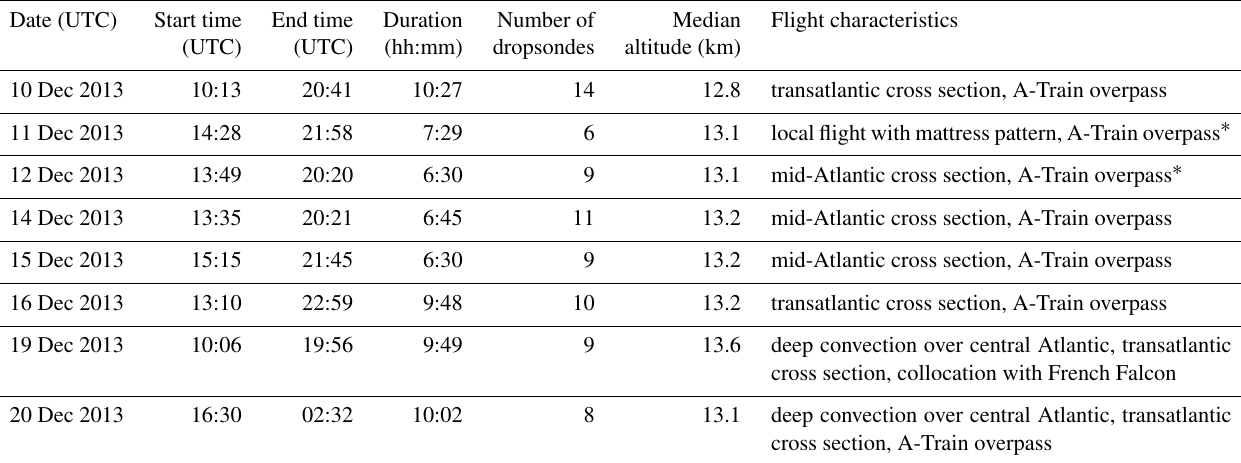
Table 1. List of NARVAL-South flights. All flights include observations of shallow trade wind convection. Additional flight characteristics are listed in the last column.